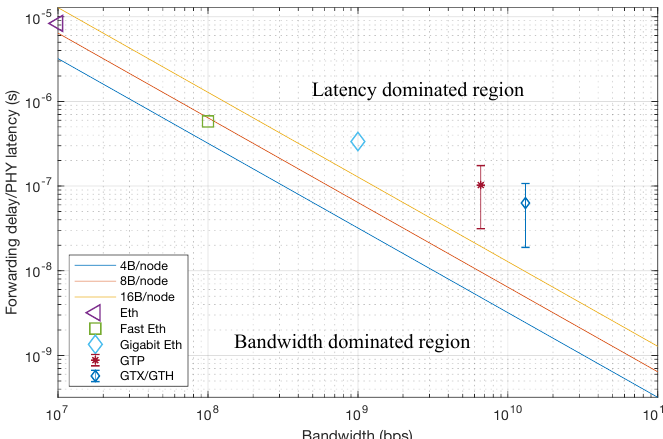
Figure 3. Critical Forwarding Delay and the forwarding delay of Ethernet and SerDes high-speed transceivers (with minimum and maximum values depending on